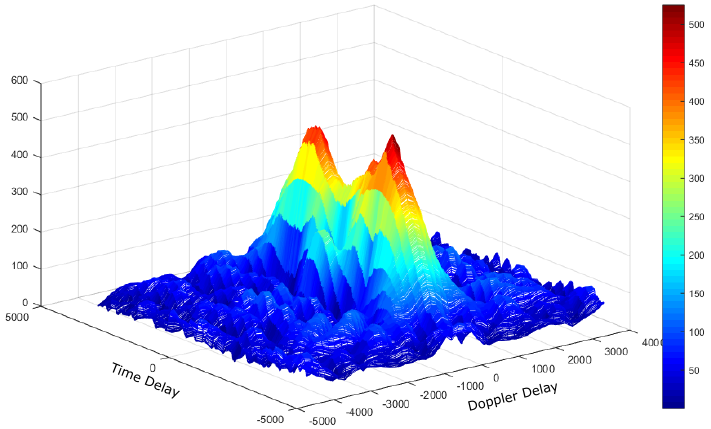
Figure 12. Two nearby scatterers using square pulses, at − 5 dB SNR.